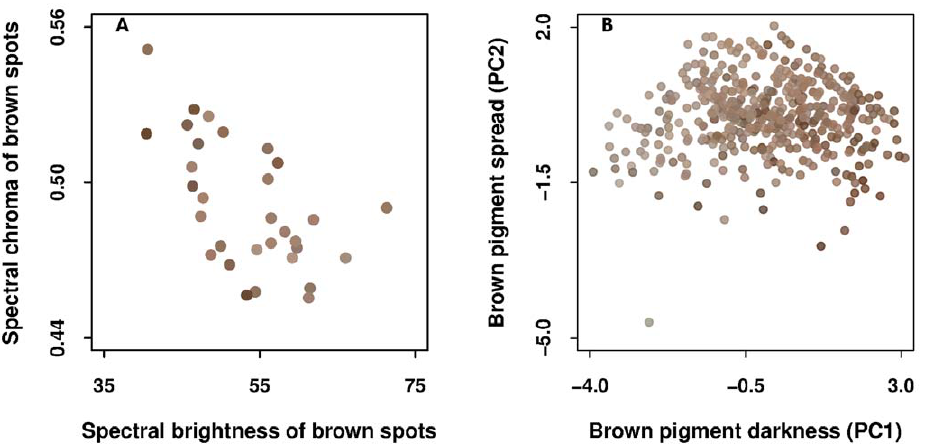
Figure 2. Relationships of spot RGB scores (i.e. dots’ color) with their spectral measures and pigmentation indices. (A) The two brown spectral variables, (B) the two principal components obtained from the three brown eggshell pigmentation indices. We increased the transparency of points (alpha=200) to improve the visibility of the 474 eggs from 42 clutches in (B). We measured the spectral coloration of the spots on a subsample of 31 eggs from 30 clutches in (A). The brown spots become browner (in response to digital saturation and hue) and darker (digital brightness) as spectral brightness decreases (A) and PC1 values increase (B). There are not such relationships with spectral chroma (A) and PC2 values (B).